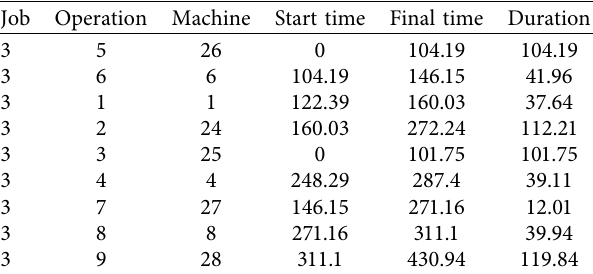
Table 14: Sequence of job 3 operations.